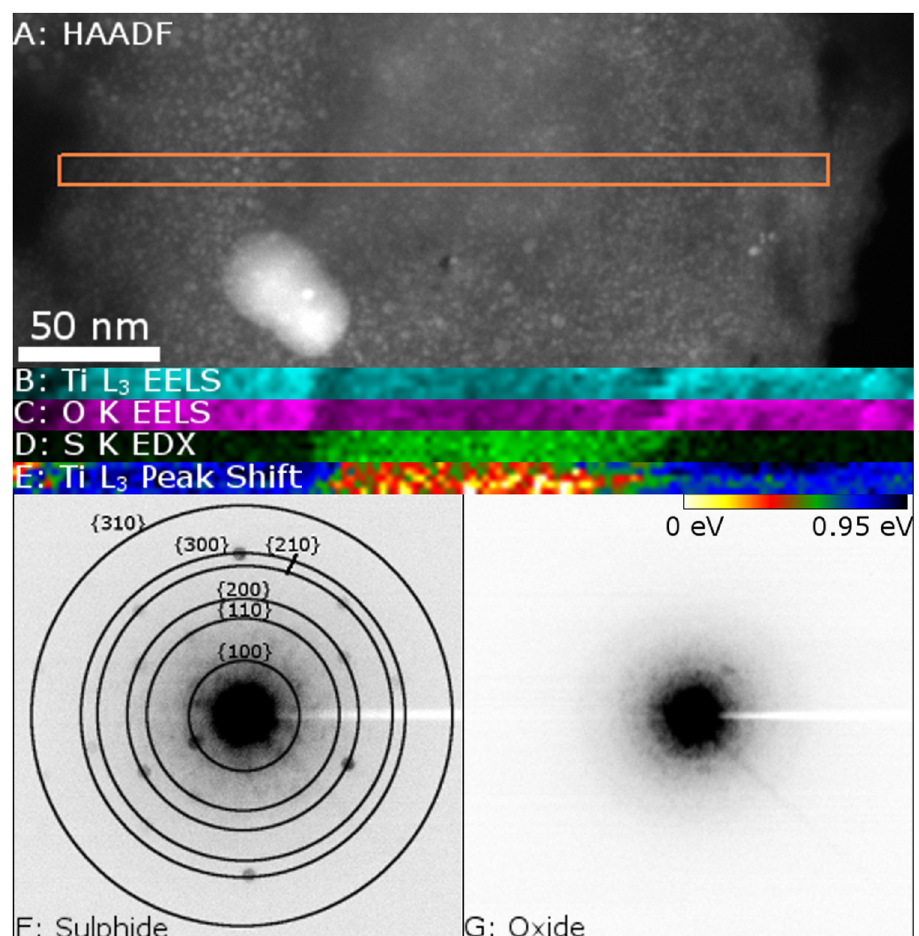
Fig. 2 State of TiS 2 after 21 days oxidation in water. a HAADF STEM of a partially oxidised fl ake of TiS 2 from which B-G were acquired in the location indicated by the orange rectangle, b Ti L 3 EELS map, c O K EELS map, d S K EDX map, e map of the peak shift on the Ti L 3 edge, f